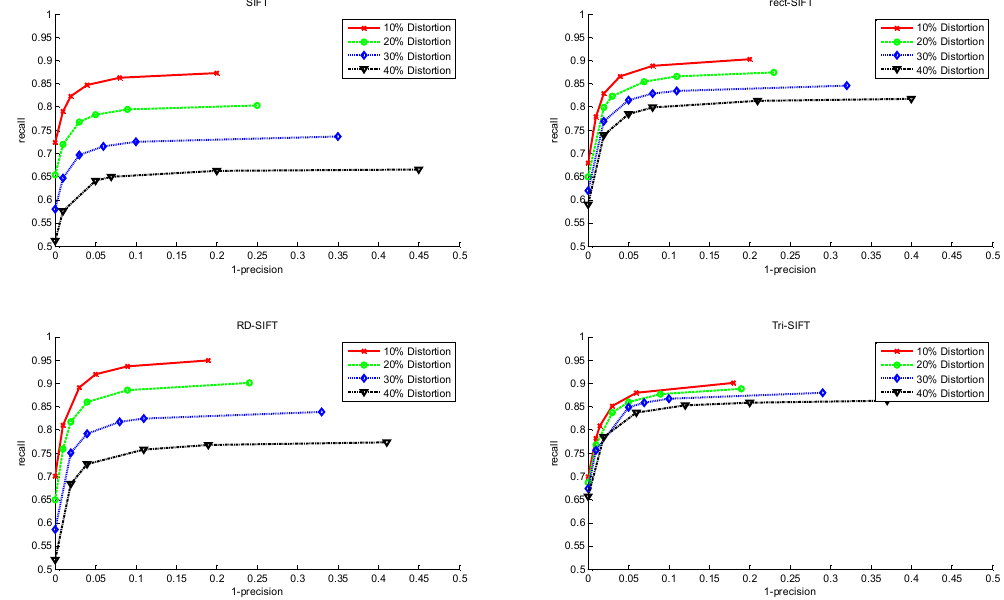
Figure 10. 1-precision vs. recall curves of the standard SIFT, rect-SIFT, RD-SIFT and tri-SIFT algorithms.